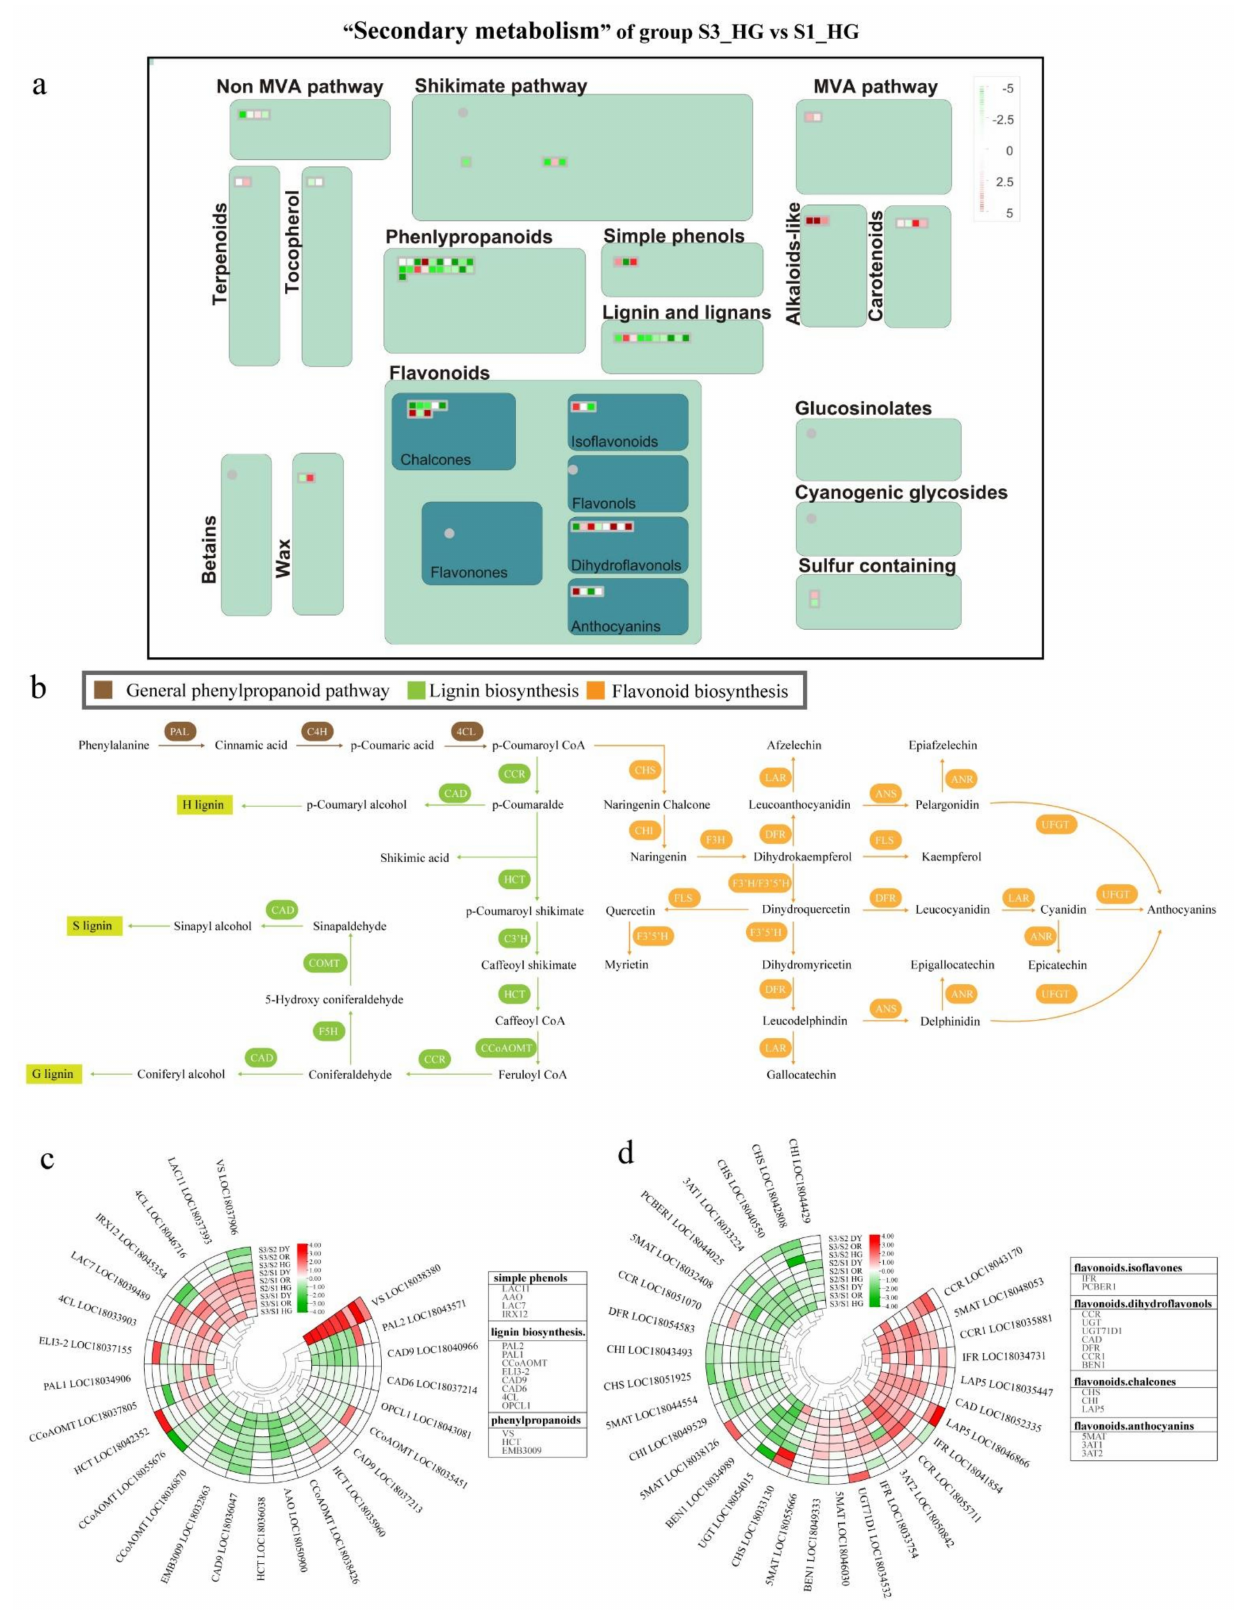
Figure 8. ( a ) MapMan-based “metabolic overview map” of DEGs in the “S3_HG vs. S1_HG” group, including modules for phenyl propane, lignans, flavonoids, mangiferylic acid, and wax. The